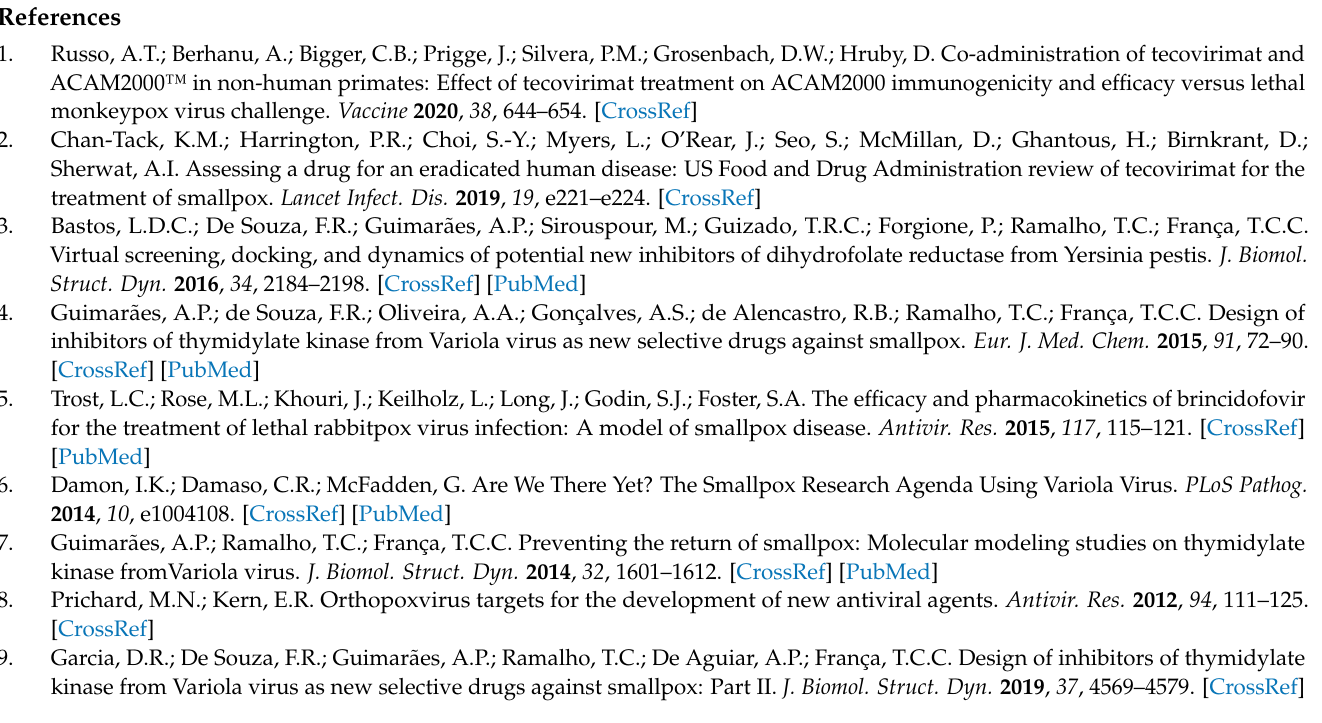
2, Figure S2: RMSD of the second MD simulation for the system HssTMPK/Compound 2, Figure S3: RMSD of the third MD simulation for the system HssTMPK/Compound 2, Figure S4: RMSD of the first MD simulation for the system VarTMPK/Compound 2, Figure S5: RMSD of the second MD simulation for the system VarTMPK/Compound 2, Figure S6: RMSD of the third MD simulation for the system VarTMPK/Compound